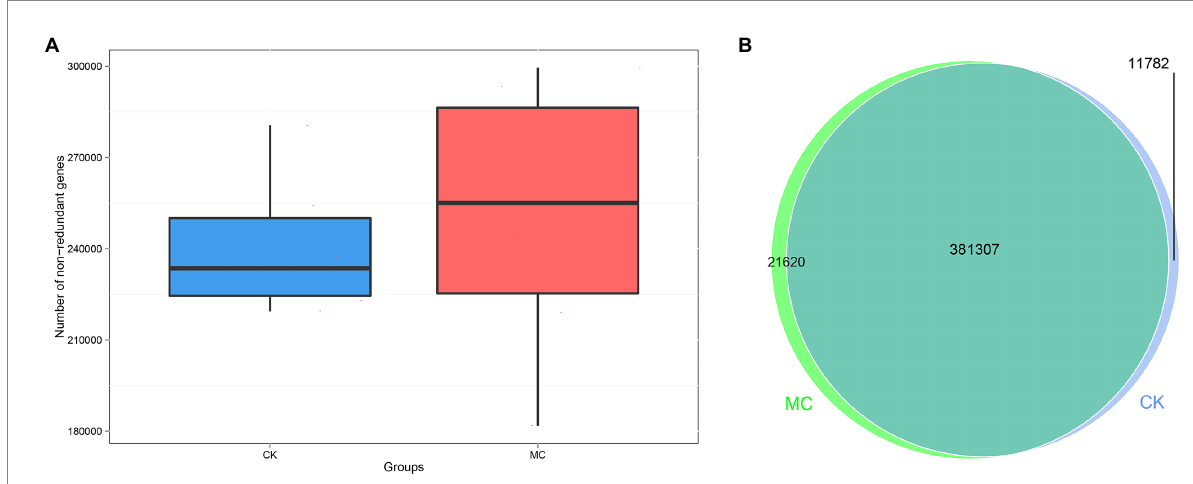
FIGURE 1 Gene numbers analysis of intestinal microbial of L. vannamei after MC-LR exposure. (A) Comparison of non-redundant genes number between the CK and MC groups. (B) Venn diagram of gene numbers between the CK and MC groups.